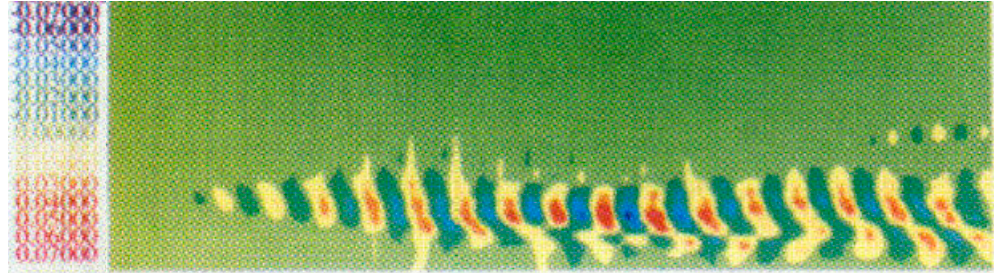
Figure 12. Lighthill stress tensor, indicating noise source at St = 0.5 (Ref. [55,58]). Appl. Sci. 2020 , 10 , x FOR PEER REVIEW